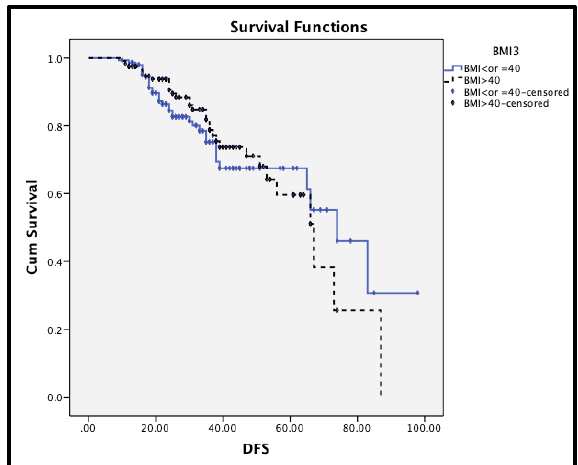
Figure 2: Kaplan Meier Curves of disease-free survival according to BMI cutoff value of